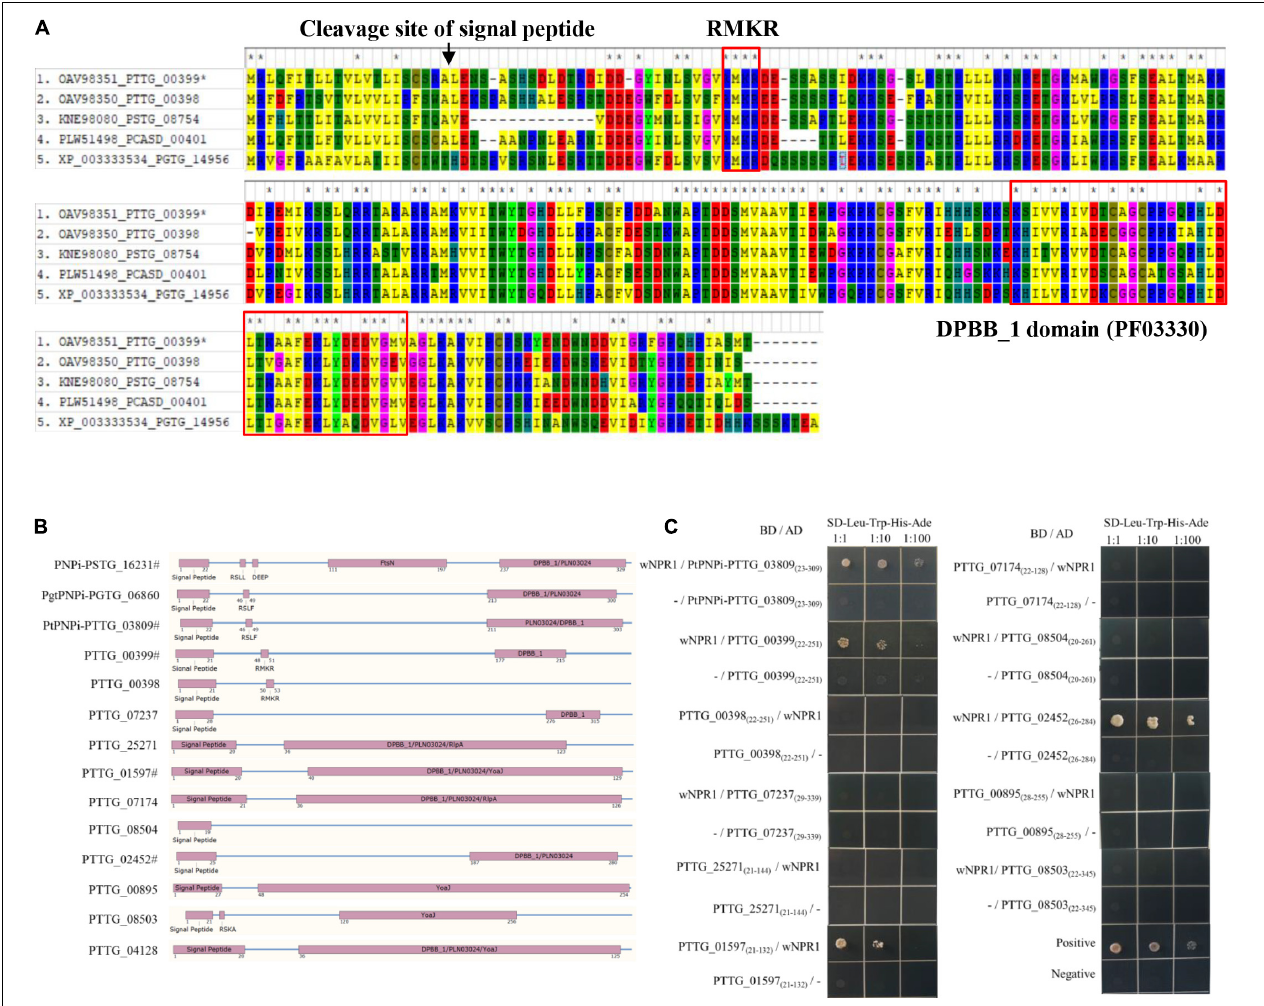
FIGURE 4 | Identification of PNPi-like effector candidates from the wheat leaf rust fungus. (A) Sequence alignment of wheat leaf rust PNPi-like effector candidate PTTG_00399 and its closest homologs from related rust species. (B) The protein structure was annotated to indicate the signal peptide, RXLR-like region, and DPBB_1 conserved domain for each of the putative PNPi-like effectors. (C) Yeast transformants co-expressing different bait and prey constructs were assayed on